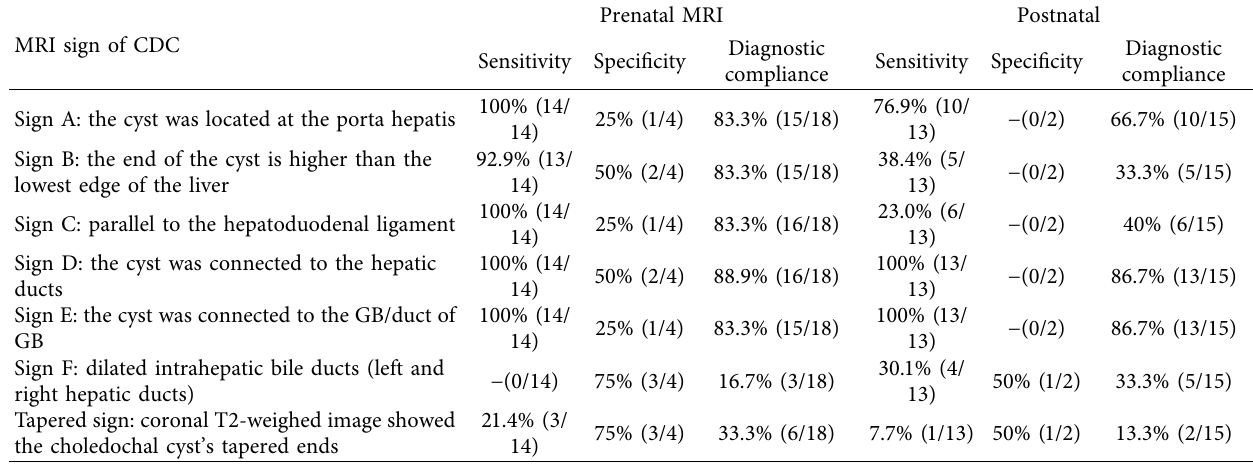
Table 3: Diagnostic test results of prenatal MR single signs in suspicious CDC